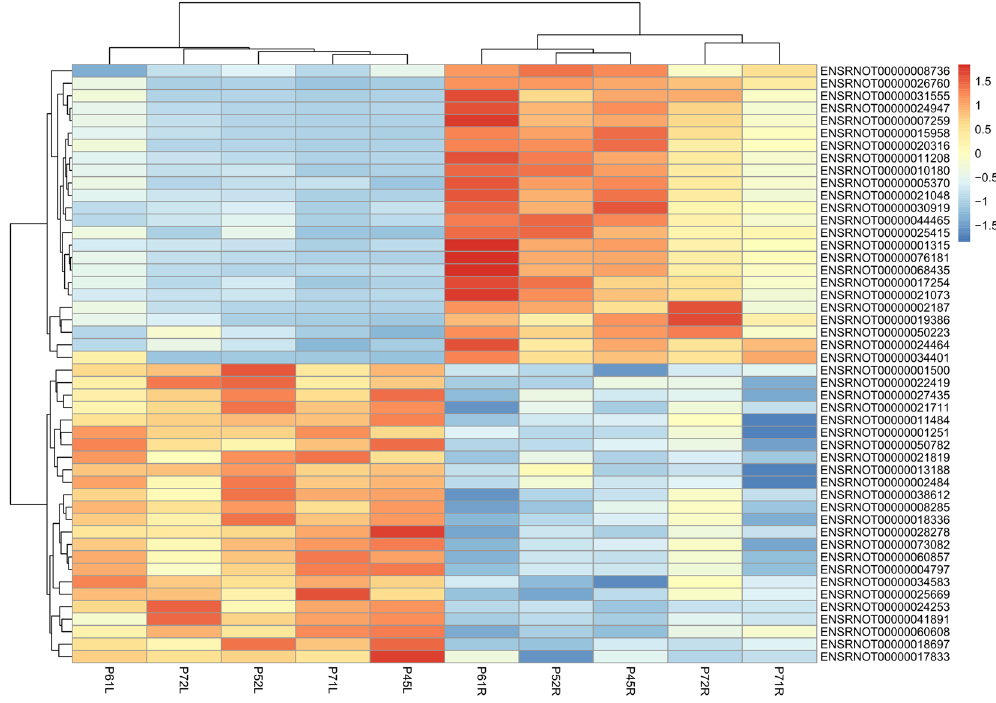
Figure 2. Heat map of DELs. The left 5 samples were from Sham group, the right 5 samples were from MCAO group. The color from blue to red shows the progression from low expression to high expression.